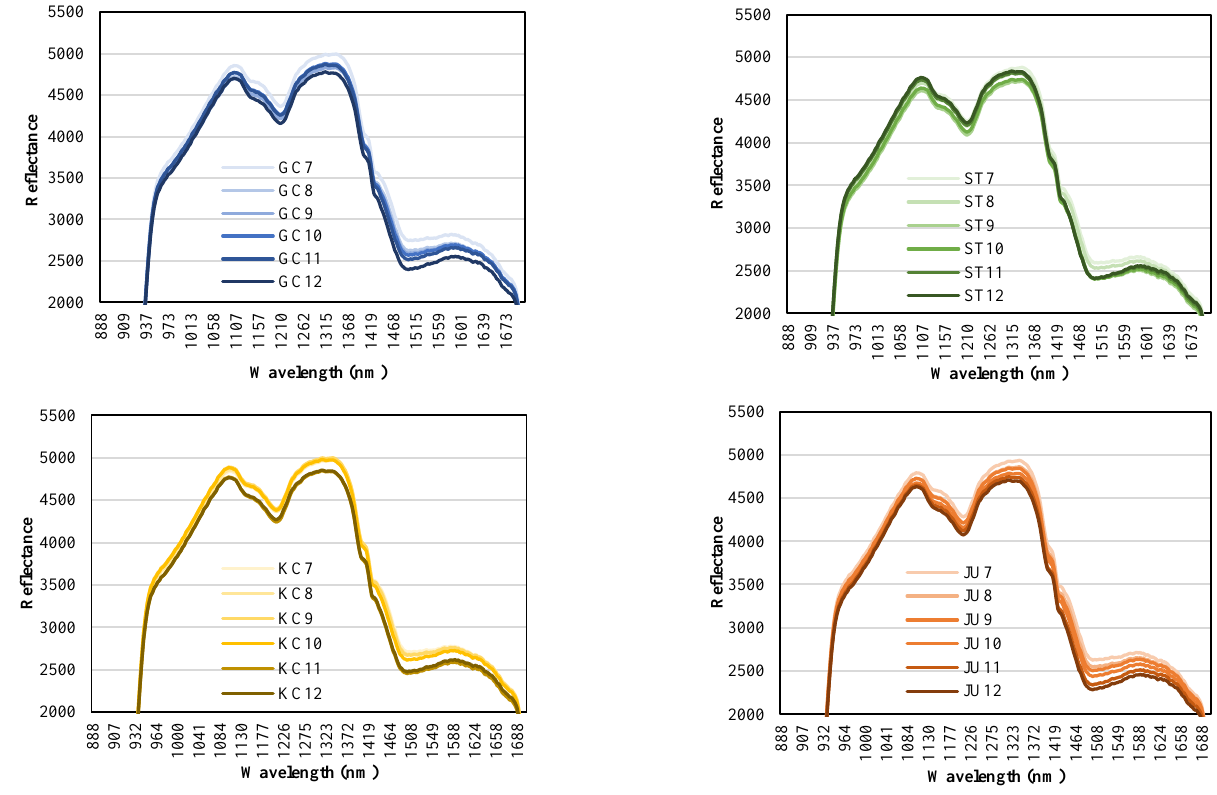
Figure 2. Mean spectra of red pepper powders in the Vis-NIR ( A ) and SWIR ( B ) wavelength ranges according to pungency levels and moisture contents.